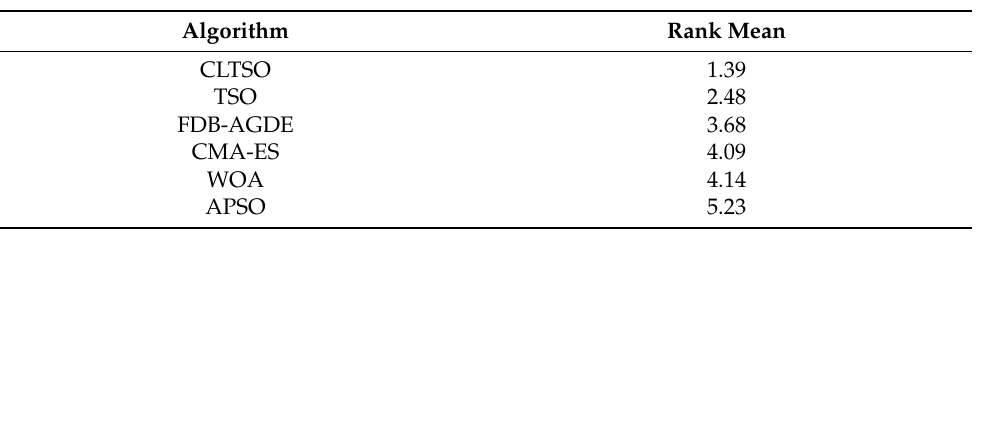
Table 7. Results of Friedman